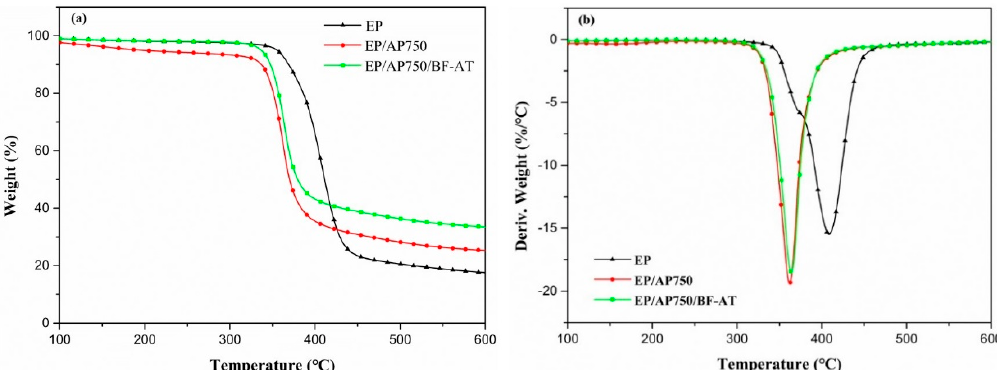
Figure 5. ( a ) TG and ( b ) DTG curves of pure EP and flame-retardant epoxy under N 2 at heating rate of 10 °C /min.